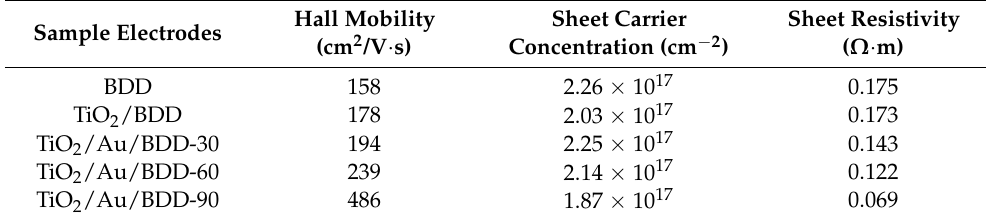
Table 1. Hall test results of the different electrodes.